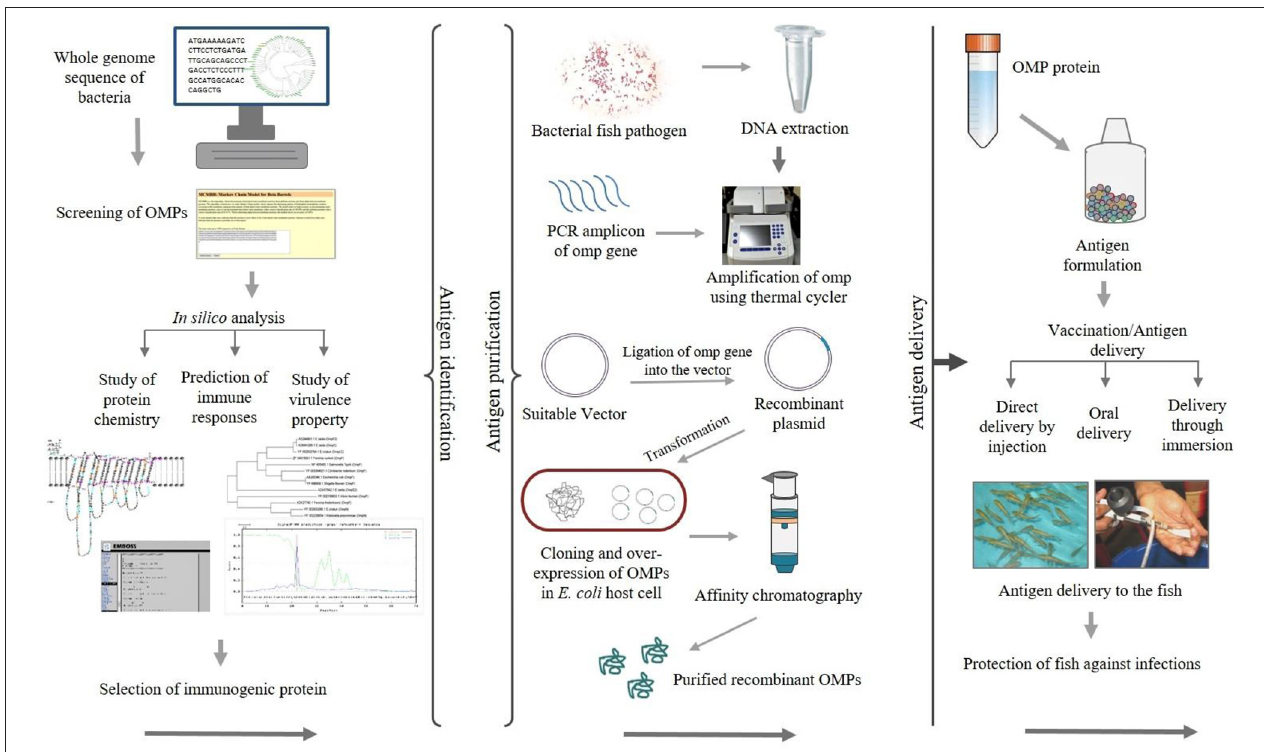
FIGURE 2 | Schematic diagram showing the application of recombinant outer membrane proteins (OMPs) through a reverse vaccinology